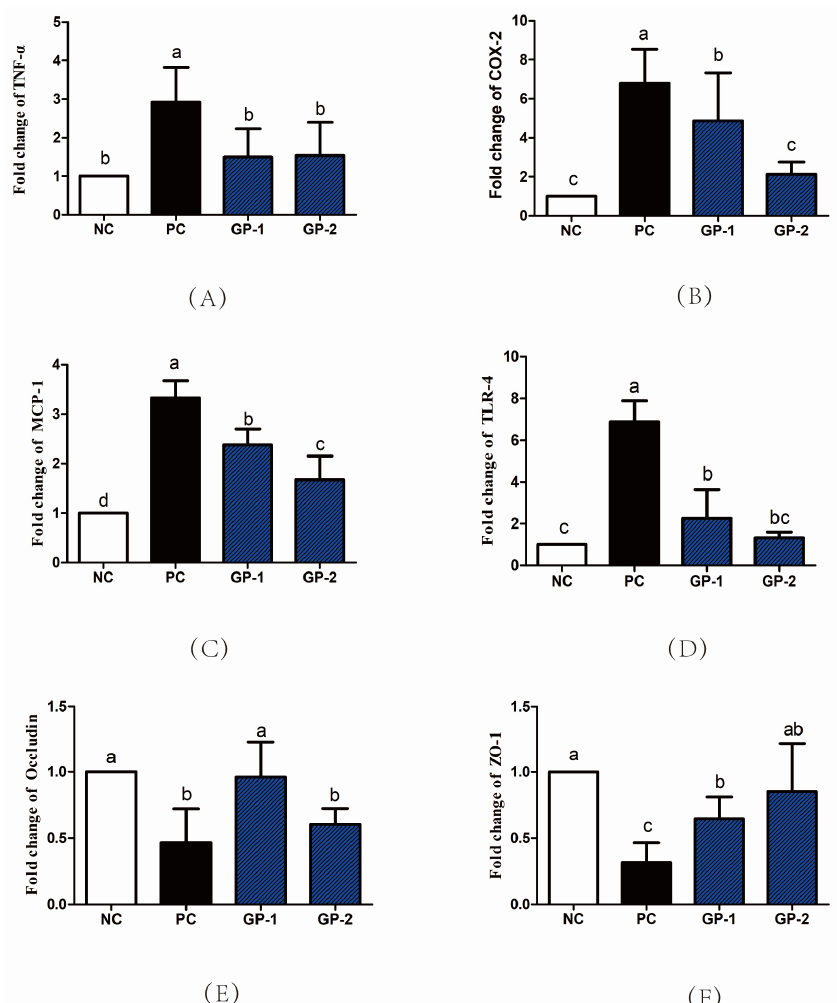
Figure 6. The mRNA expression levels of inflammatory cytokines and intestinal receptor proteins. The TNF- α ( A ), COX-2 ( B ), MCP-1 ( C ), TLR-4 ( D ), Occludin ( E ), ZO-1 ( F ) expression in colon tissues were measured by RT-PCR. All values represent the means ± SD ( n = 8) and the differences among groups were analyzed by one-way ANOVA (Tukey’s Multiple Comparison Test). The different letters mean significant differences of p < 0.05.